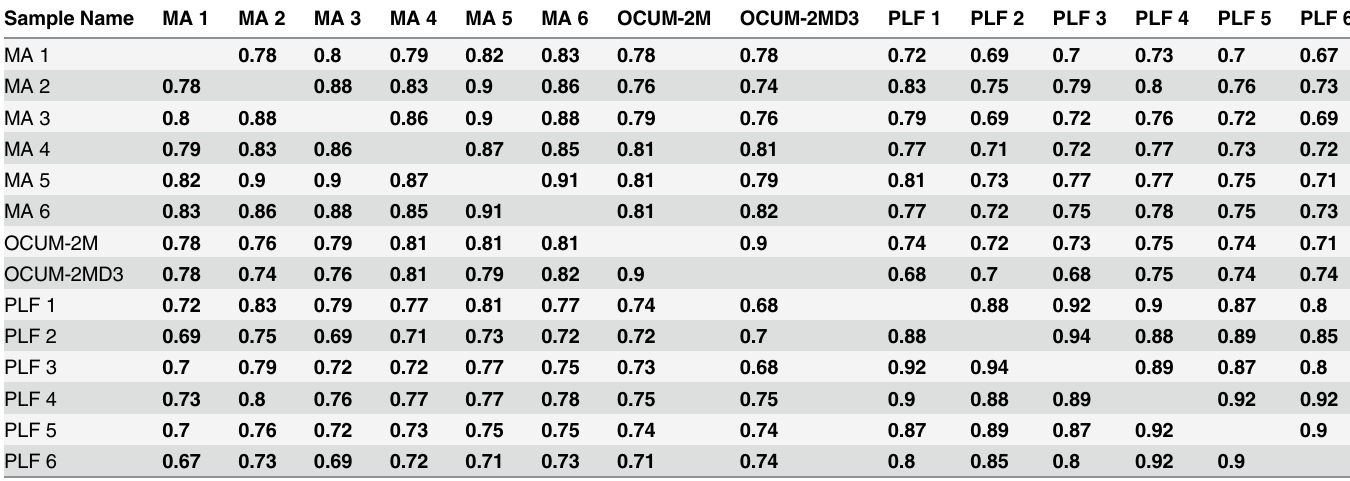
Table 2. Coefficient of correlation between samples. MA, Malignant ascites; PLF, Peritoneal lavage fluid; CM, Cell culture medium Sample Name